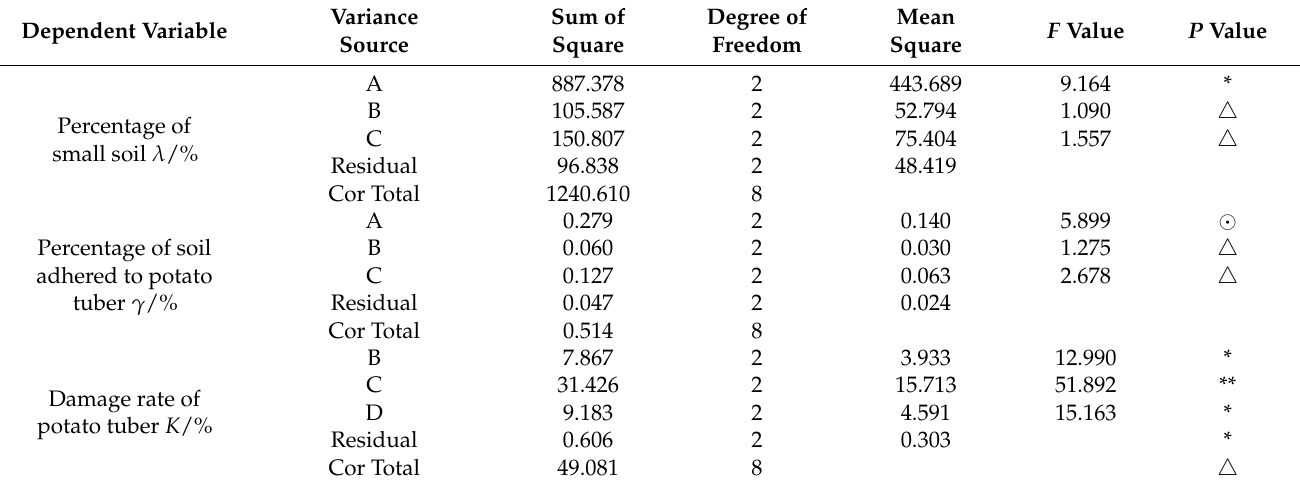
Figure 12. Means graph of a different index at the individual level of the respective factor. ( a ) Percentage of small soil; ( b ) percentage of soil that adhered to potato tubers; ( c ) damage rate of potato tuber. Table 4. Results of variance